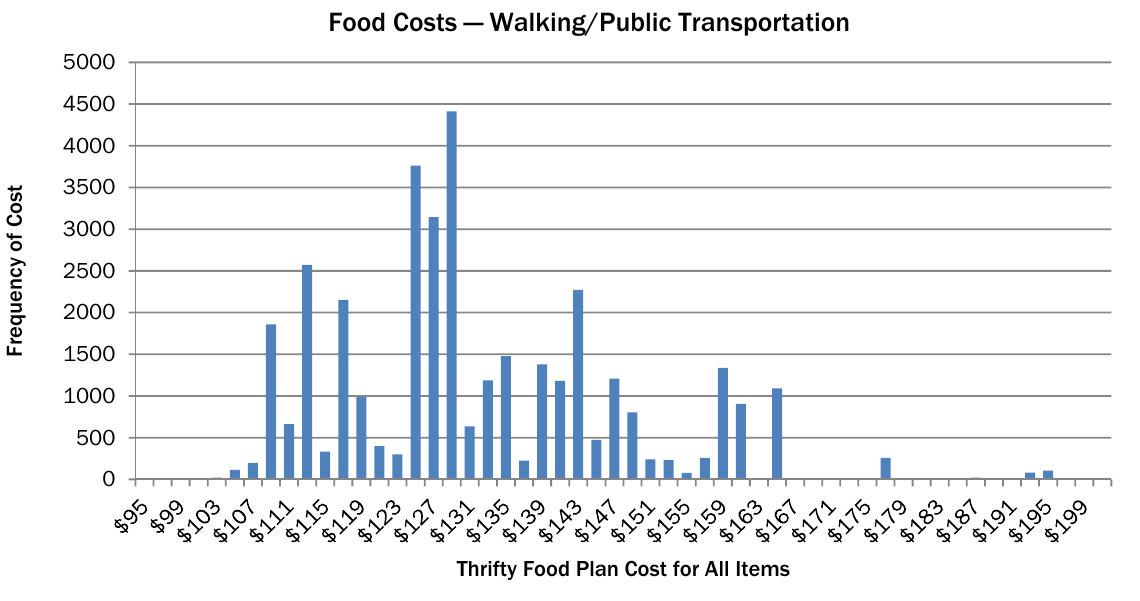
Figure 7. Variation in total cost of the USDA Thrifty Food Plan for the food items alone in the Gulf Coast counties of Mississippi, during Spring 2011, assuming that all items are purchased and the shopper uses stores that provide the lowest cost combination of food price and transportation cost by walking and public transportation by